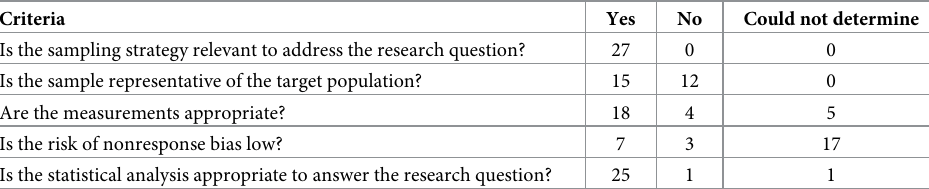
Table 4. Quality assessment of